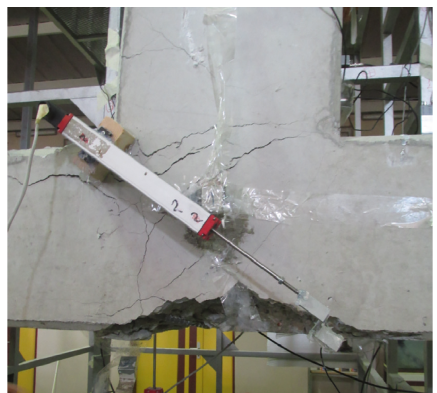
Figure 10: Failure of the control